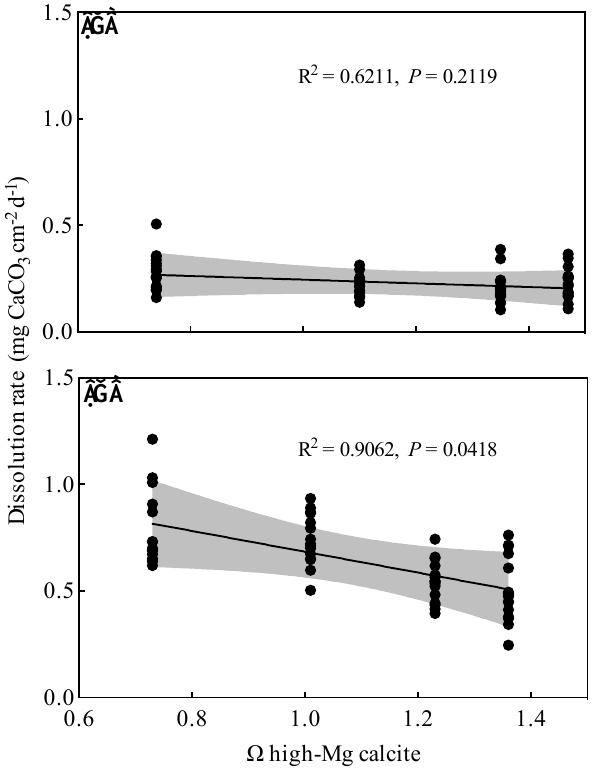
Figure 2. Linear dissolution response of CCA skeletons to declin- ing saturation state of seawater with respect to HMC ( (cid:127) HMC ) over Fig 2. Linear dissolution response of CCA skeletons to declining saturation state of seawater 8 weeks under (a) natural light (photosynthetic microborers + en- vironmental effect) and (b) dark conditions (environmental effect). Dissolution data correspond to means ± SEM ( n = 16 samples per with respect to high-Mg calcite ( " ) over 8 weeks under (A) natural light (photosynthetic HMC light condition and p CO 2 -T treatment) and (cid:127) HMC values corre- spond to means calculated for light and dark tanks ( n = 9). The microborers + environmental effect) and (B) dark conditions (environmental effect). solid curves represent the linear regression and the grey areas rep- resent the 95% confidence interval of the